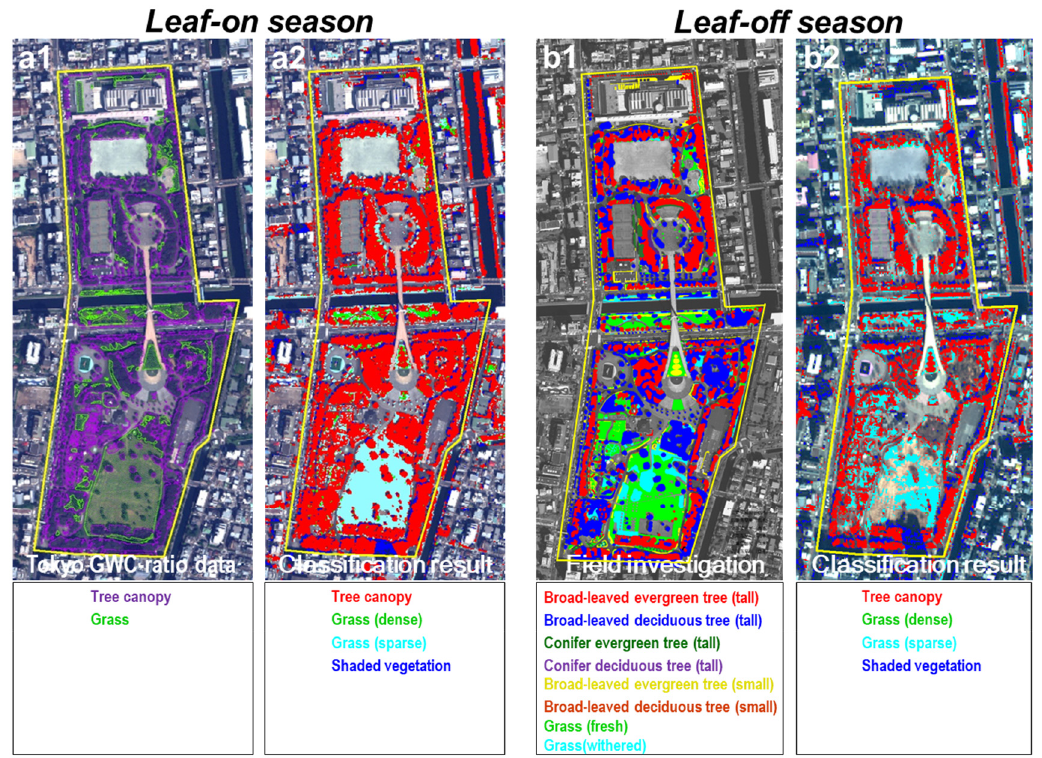
Figure 5. Mapping results of vegetation in the test area shown in Figure 2 ( A3 and B3 ). ( a1 ) Map of the tree canopy (purple) and grass (green) based on the Tokyo GWC-ratio data. ( b1 ) Vegetation cover, which was manually delineated based on field observations. ( a2 and b2 ) Vegetation cover estimated from WorldView-2 / 3 imagery. The areas enclosed by yellow lines represent where the comparisons were performed. Satellite imagery from DigitalGlobe Products. ( a1 and a2 ) WorldView3 © 2020 DigitalGlobe, Inc., a Maxar company. ( b1 and b2 ) WorldView2 © 2020 DigitalGlobe, Inc., a Maxar company. Table 4. Classification accuracy of tree canopy cover (%) from WorldView-2/3 imagery for two test areas in Figures 4 and 5.